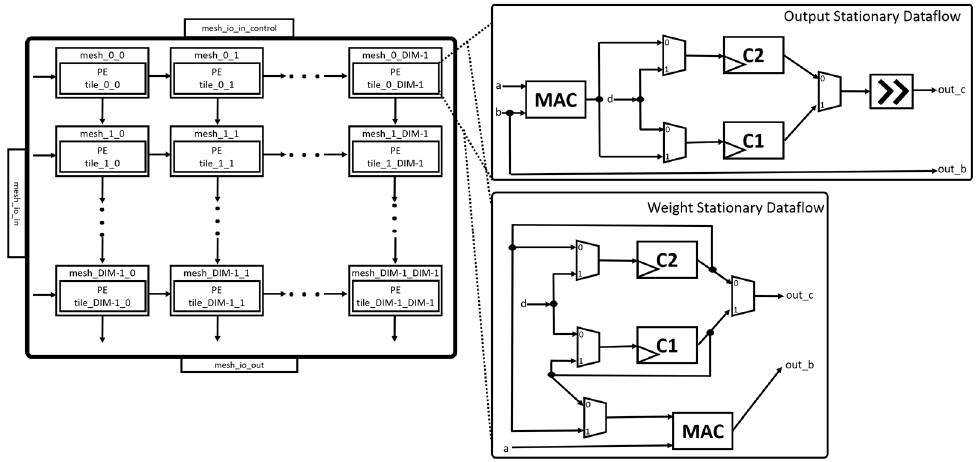
Figure 8. Mesh module.